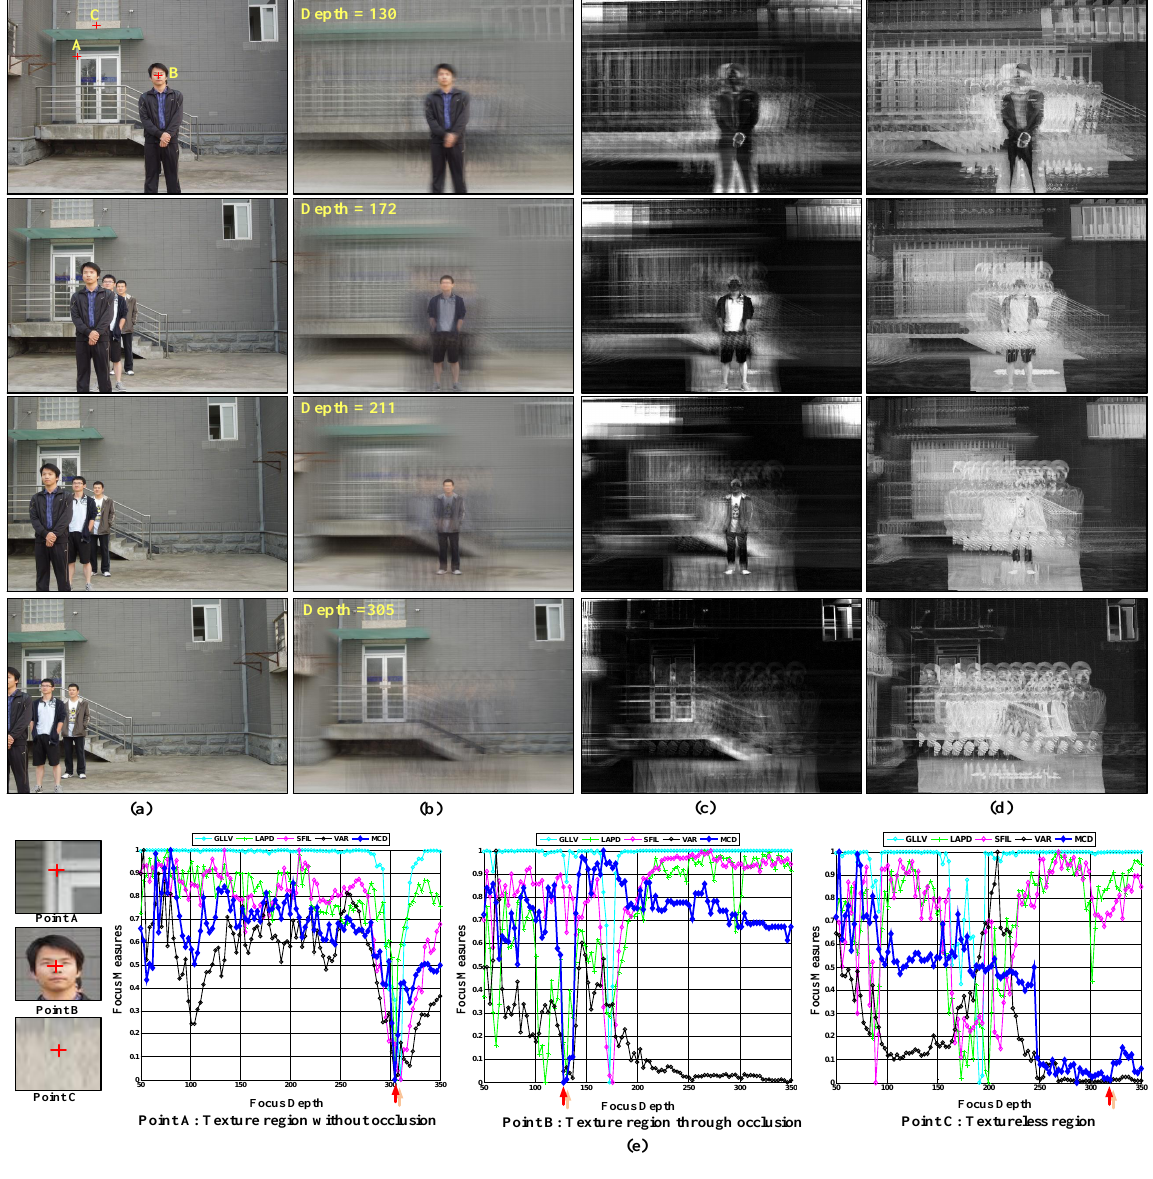
Figure 5. Comparison results of focus measures for different kinds of points; the manually-labeled ground truth focus depth is marked with the red arrow. ( a ) Multiple view images; ( b )Synthetic Aperture Image; ( c ) Variance Image; ( d ) Our MCD Image; ( e ) Comparison results of different focus measures, variance and maximal color difference